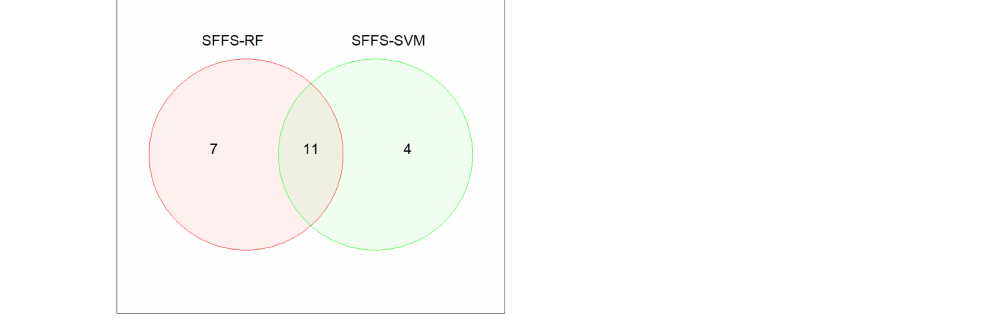
Figure 4. Identification of common features from SFFS-RF and SFFS-SVM for handwritten text dataset. Table 6. List of common features selected for handwritten text dataset .